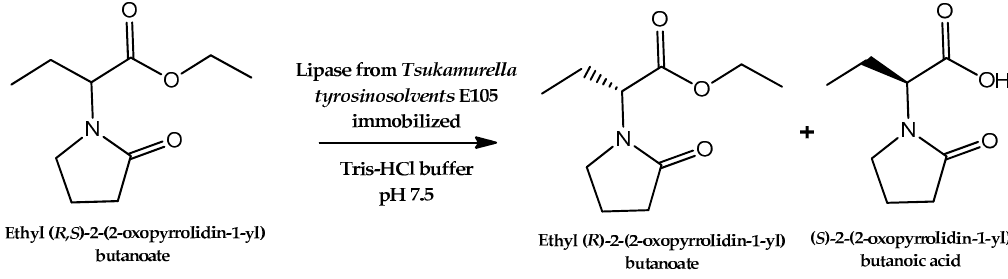
Figure 19. Enantioselective hydrolysis of ( R ,S)-ethyl 2-(2-oxopyrrolidin-1-yl) butyrate catalyzed by the lipase from Tsukamurella tyrosinosolvents E105 immobilized in calcium alginate/carrageenan beads.